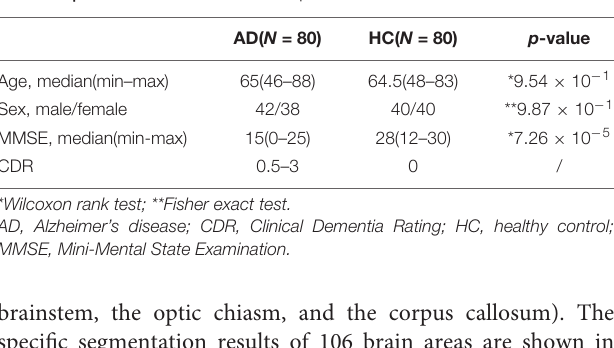
Frontiers in Aging Neuroscience |